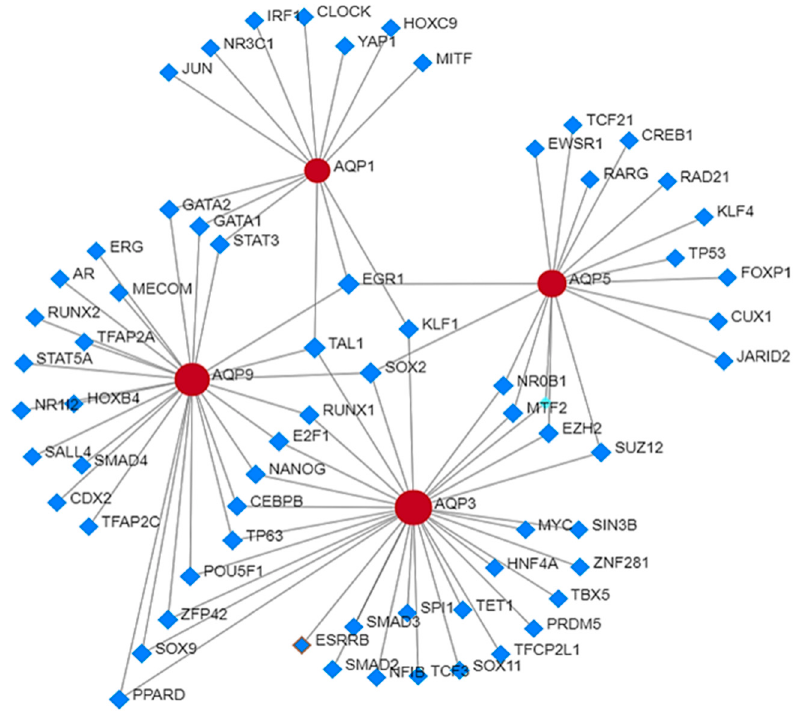
Figure 3. Protein–protein interaction analysis of AQPs with other proteins in prostate cancer.